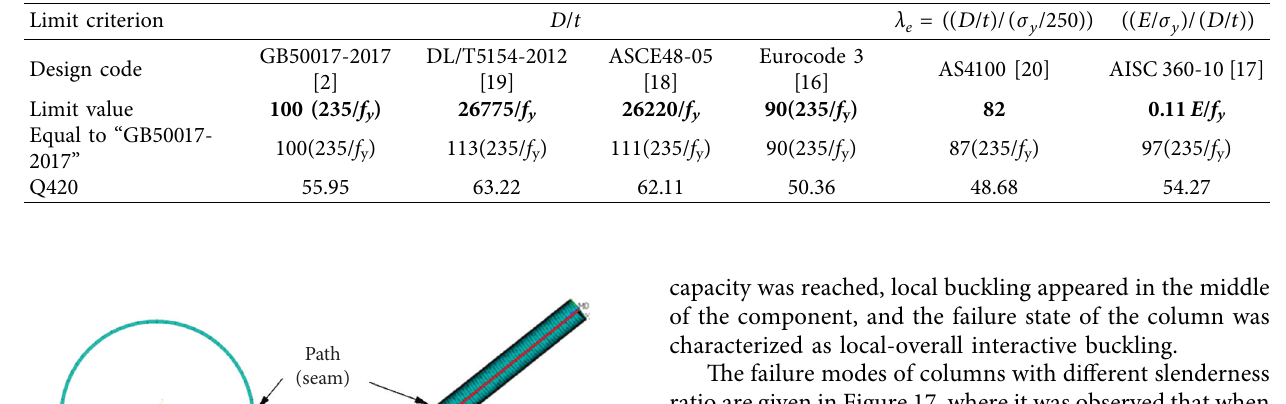
Table 5: Existed local buckling limit for circular tubes.